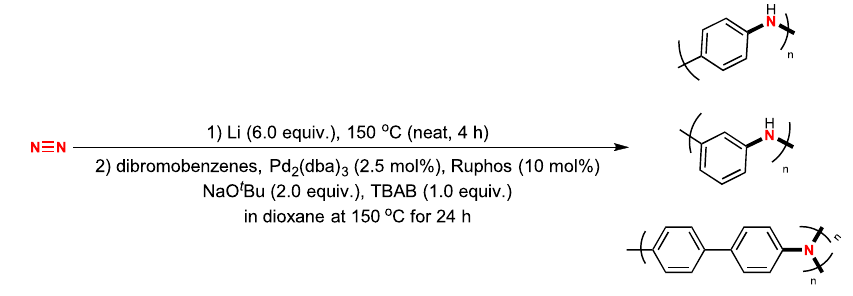
Fig. 4 Synthesis of polyanilines. Synthesis of structural diversi fi ed PANS through direct nitrogenation using dinitrogen (N 2